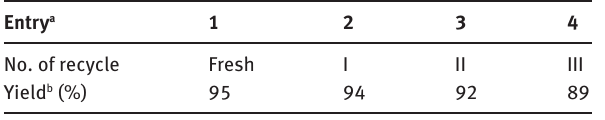
a Reaction condition: 4-bromobenzaldehyde (1 mmol), 2-amino thio- phenol (1 mmol), MoO nanorods. 3 b Isolated yield.